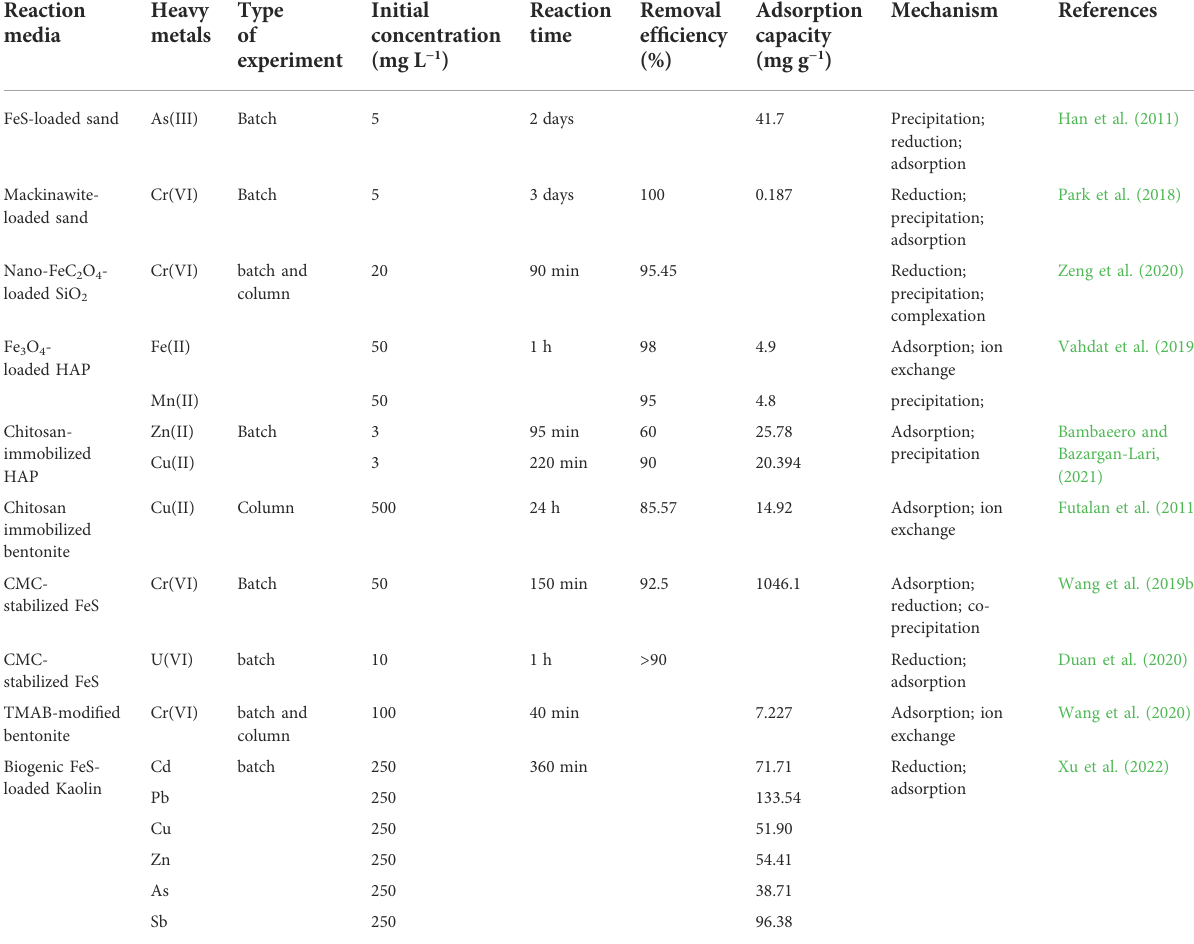
TABLE 6 Application of mineral-related composite materials in PRB treatment of groundwater heavy